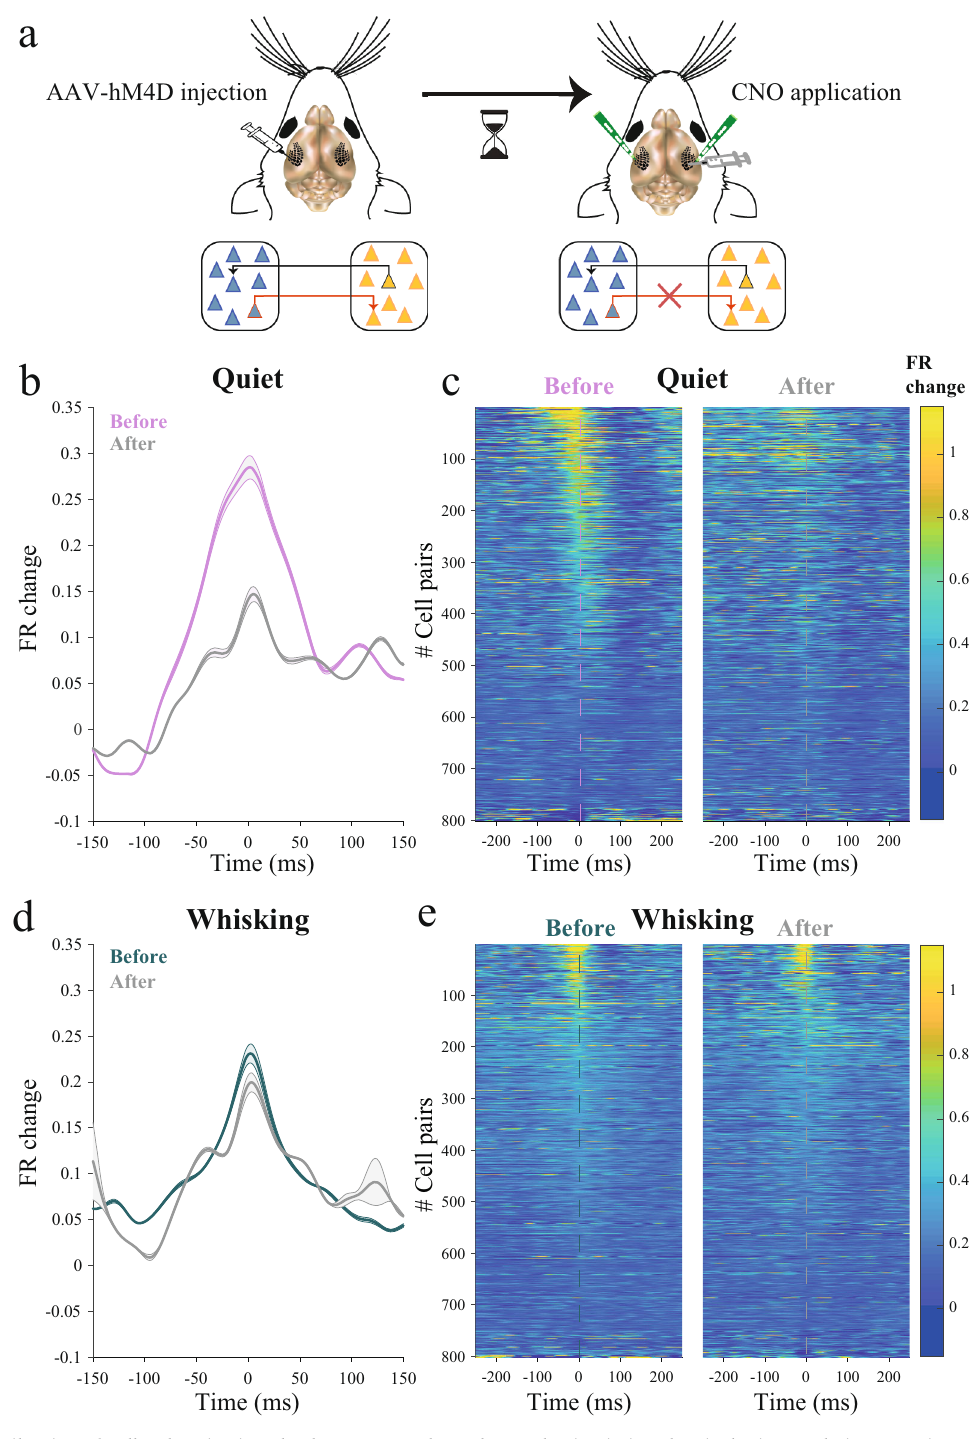
Fig. 4 Unilateral silencing of callosal projections leads to a state-dependent reduction in interhemispheric correlations. a Schematic diagram of the injection and experiment. hM4D was expressed in the left hemisphere and following expression extracellular recordings were made simultaneously from both barrel cortices. CNO was topically applied to the right barrel cortex, silencing callosal terminals arising from the left hemisphere. b, d Population average of spike trigger average (STA) between the hemispheres before and after application of CNO as calculated during quiet wakefulness ( b ) and whisking ( d ) (mean (line) ± SEM (shaded), p < 0.001, two-sided WSRT, n = 802 pairs). Shuf fl ed STAs were subtracted (see Methods). c, e STAs between hemispheres before (right) and after (left) application of CNO, showing all pairs during quiet wakefulness ( c ) and whisking ( e ). Both panels are ordered identically, based on mean peak STAs obtained from both